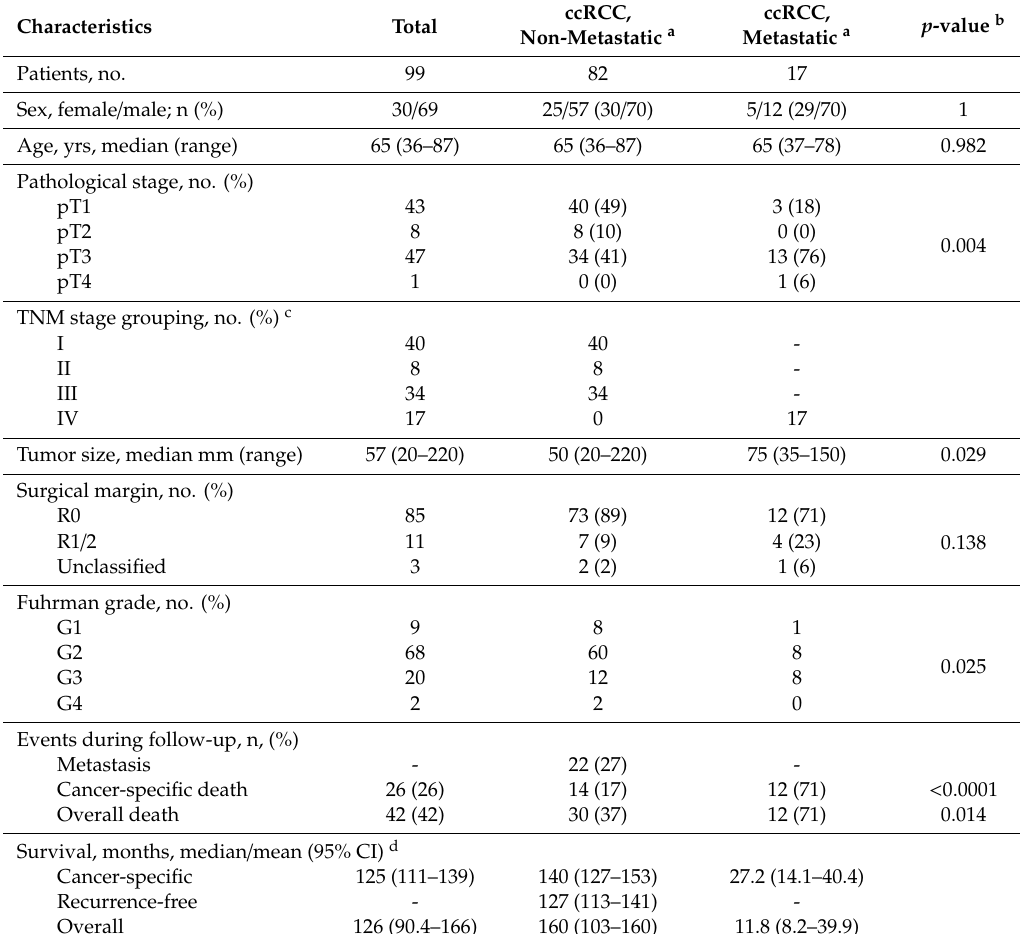
Table 1. Characteristics of the ccRCC